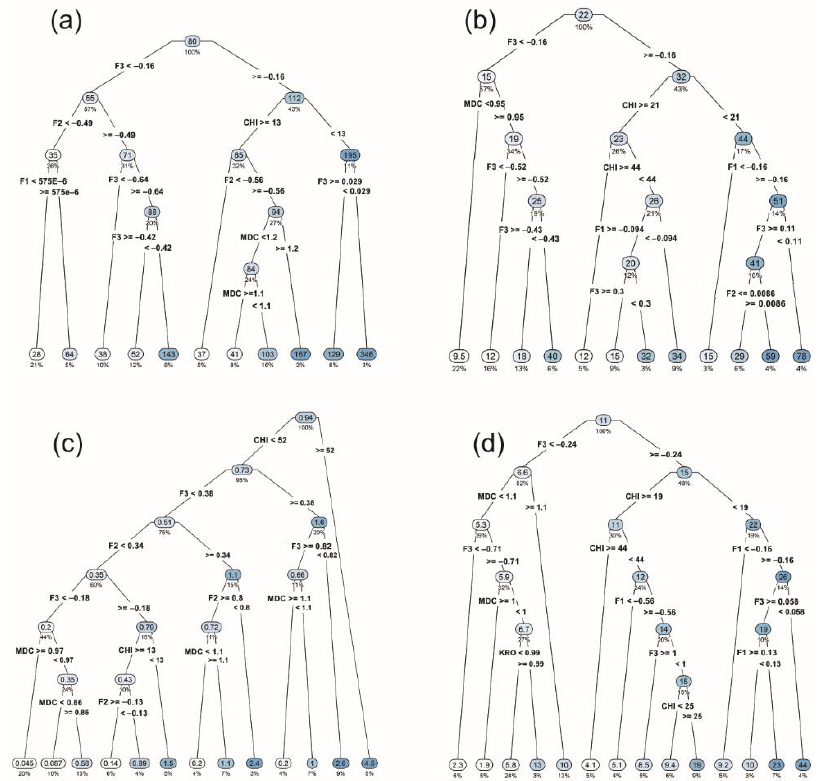
Figure 3. Regression trees for road traffic crashes in ( a ) rain ( b ) snow, ( c ) wind, and ( d ) fog.